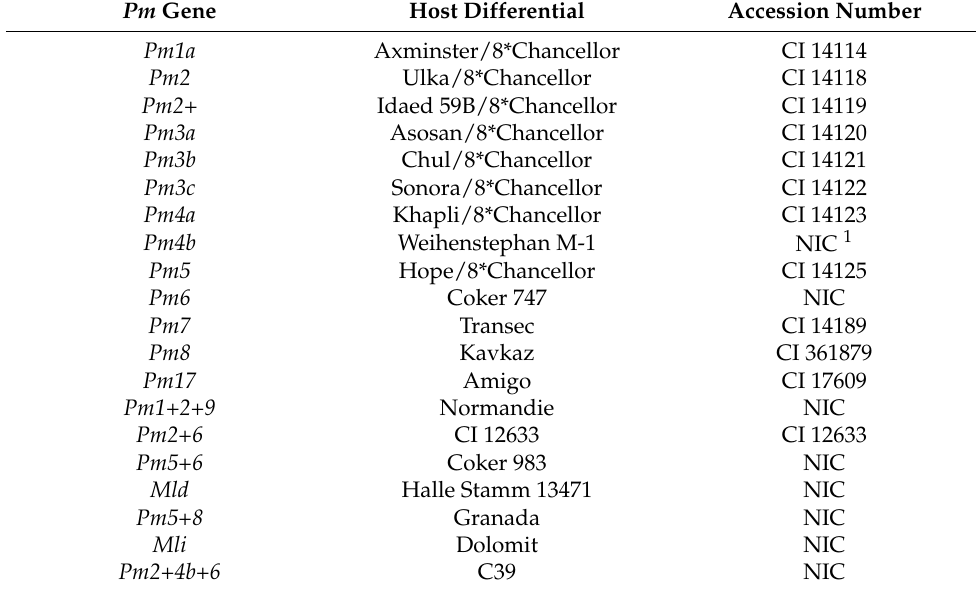
Table 1. Host differentials and genes used in virulence tests of Blumeria graminis f. sp. tritici isolates. Pm Gene Host Differential Accession Number Pm1a Axminster/8*Chancellor CI 14114 Pm2 Ulka/8*Chancellor CI 14118 Pm2+ Idaed 59B/8*Chancellor CI 14119 Pm3a Asosan/8*Chancellor CI 14120 Pm3b Chul/8*Chancellor CI 14121 Pm3c Sonora/8*Chancellor CI 14122 Pm4a CI 14123 Pm4b NIC 1 Pm5 CI 14125 Pm6 Coker 747 NIC Pm7 Transec CI 14189 Pm8 Kavkaz CI 361879 Pm17 Amigo CI 17609